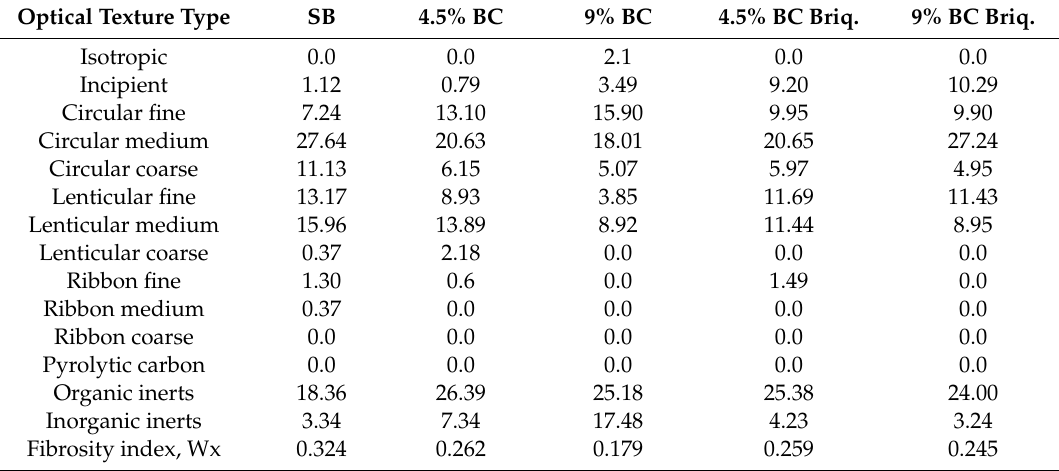
Table 3. Qualitative and quantitative analysis of the coke optical texture and calculation of the fibrosity index W x